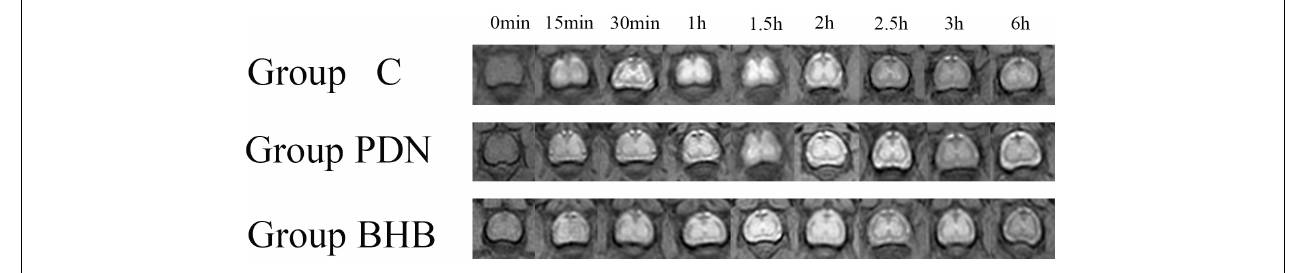
FIGURE 3 | The MRI image with time in lumbar enlargement of the spinal cord of rats in Group C, Group PDN, and Group BHB before and after 25 µ l diluted gadolinium-diethylenetriamine penta-acetic acid (Gd-DTPA, 75 µ l Gd-DTPA was diluted with 925 µ l sterile saline) injection (0 min–6 h) through the lumbar 4/5 intervertebral space. Refer to Figure 1 for the meaning of the grouping